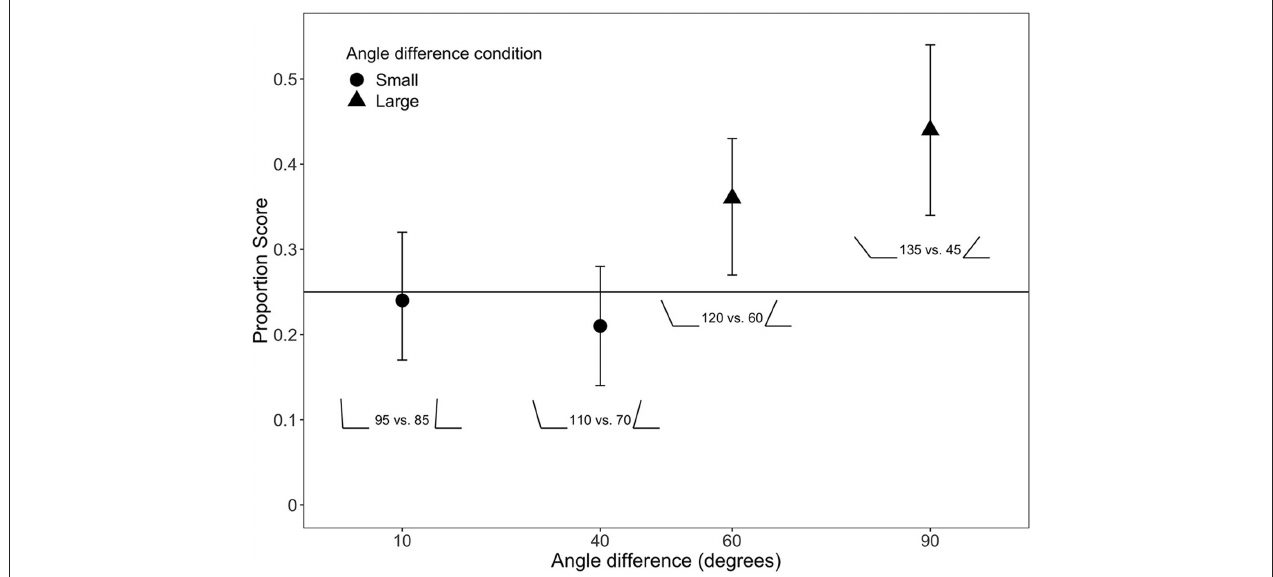
FIGURE 2 | Mean proportion score in the four conditions. Angles show the two to-be-compared angles in each condition. Horizontal line denotes chance level. Vertical bars denote 95% BCa bootstrapped confidence intervals for the mean.